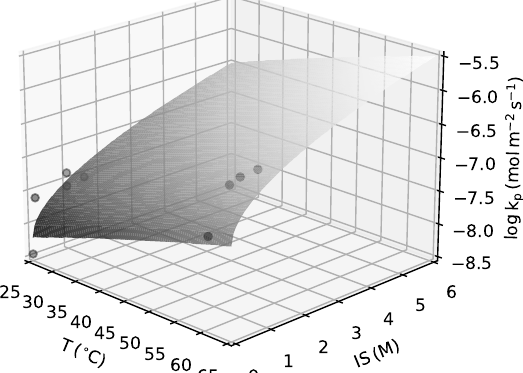
Figure 3. Kinetic rate constant for barite bulk precipitation as a function of temperature and ionic strength (Equation (6)). The dots represent experimental data from Zhen-Wu et al. [32].